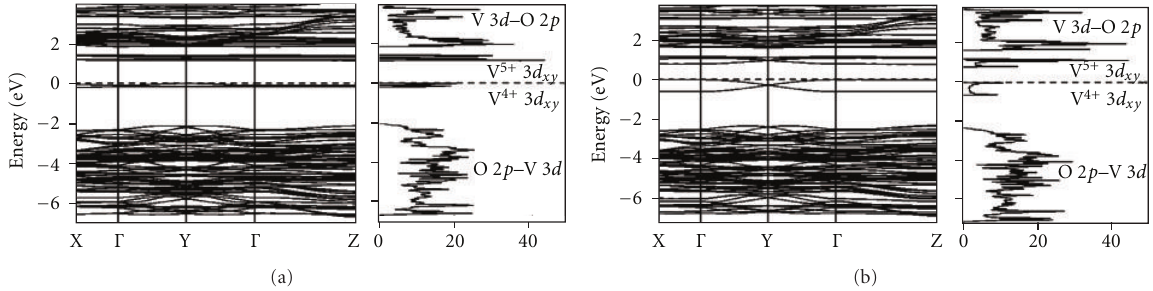
Figure 32: LDA+ U band structure and the total DOS for two di ff erent kinds of magnetic ordering of V 4+ moments within the zig-zag CO model with (a) AF intra-chain and F inter-chain ordering and (b) F intra-chain and AF inter-chain ordering [245].